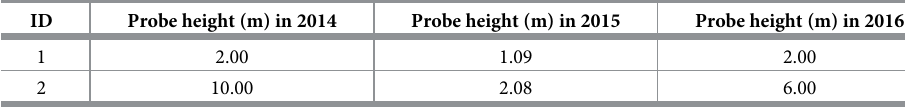
Table 1. Installation data of the ultrasonic 3D